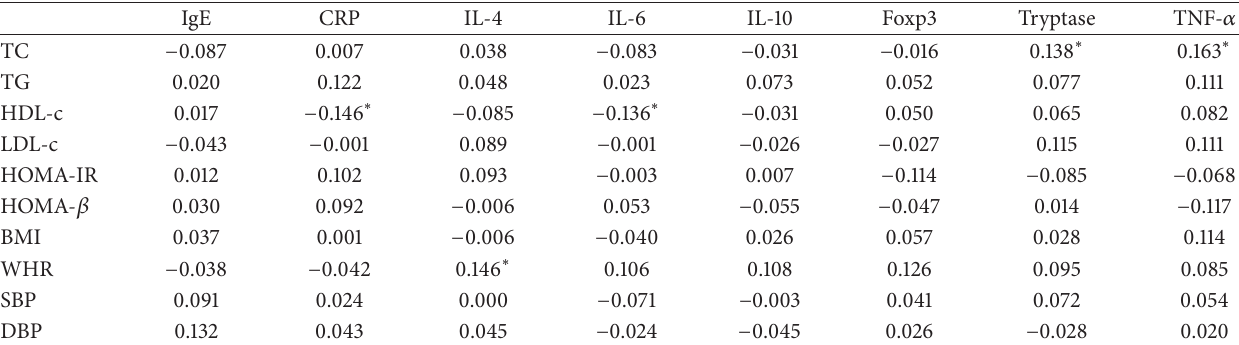
Table 4: Spearman correlation coefficients between inflammatory markers and cardiovascular factors in normal glucose